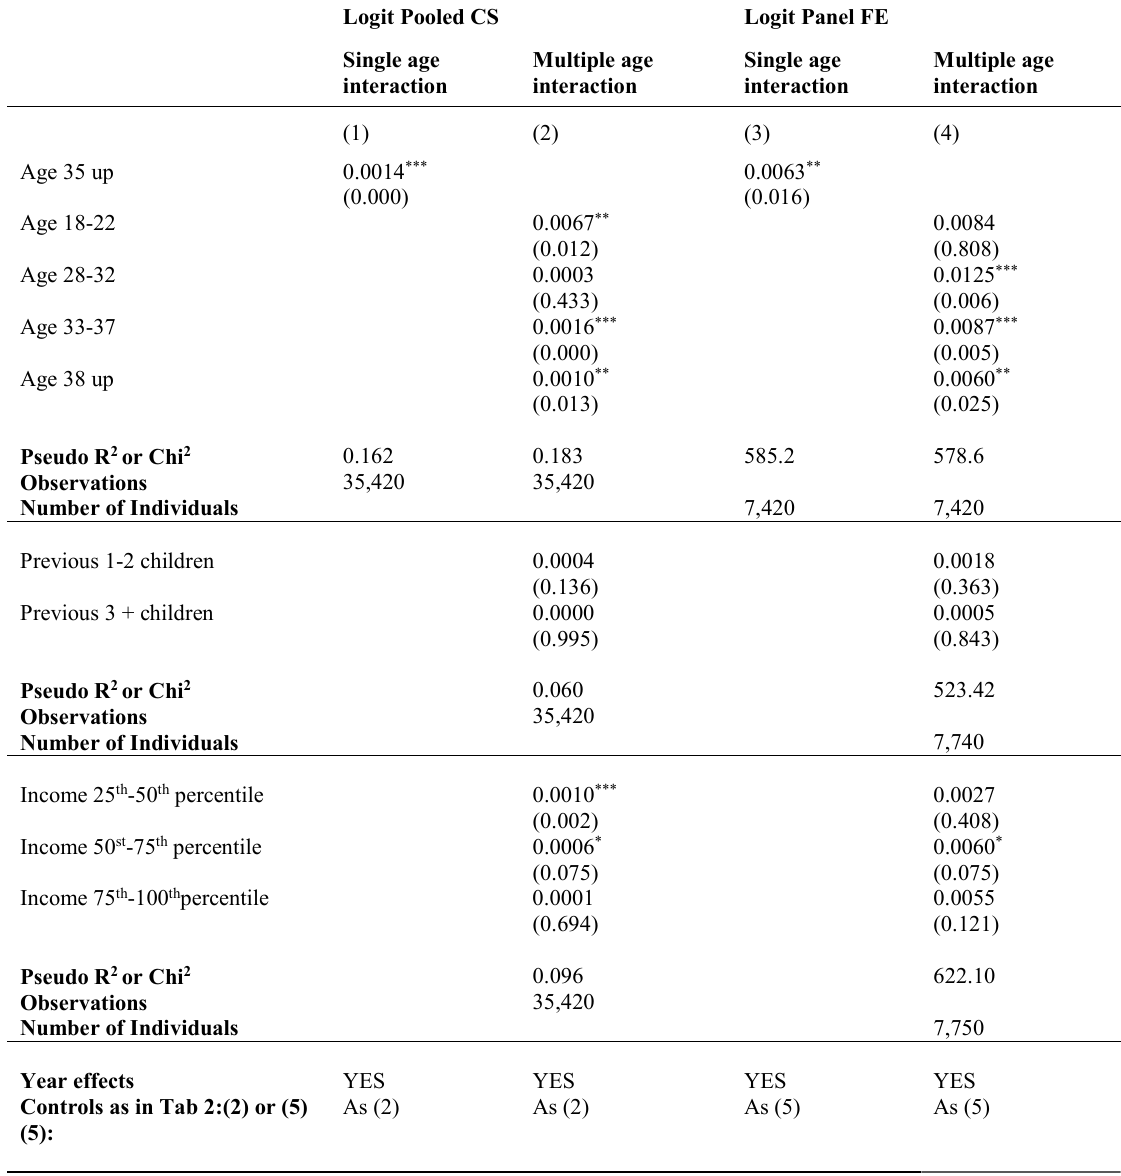
Table 5: Predicted effect of $10,000 rise in house price by age, previous children, household income, and a increasing time lag (excluding movers outside REB, p-values in parentheses) Logit Pooled CS Logit Panel FE Single age Multiple age Single age Multiple age interaction interaction interaction